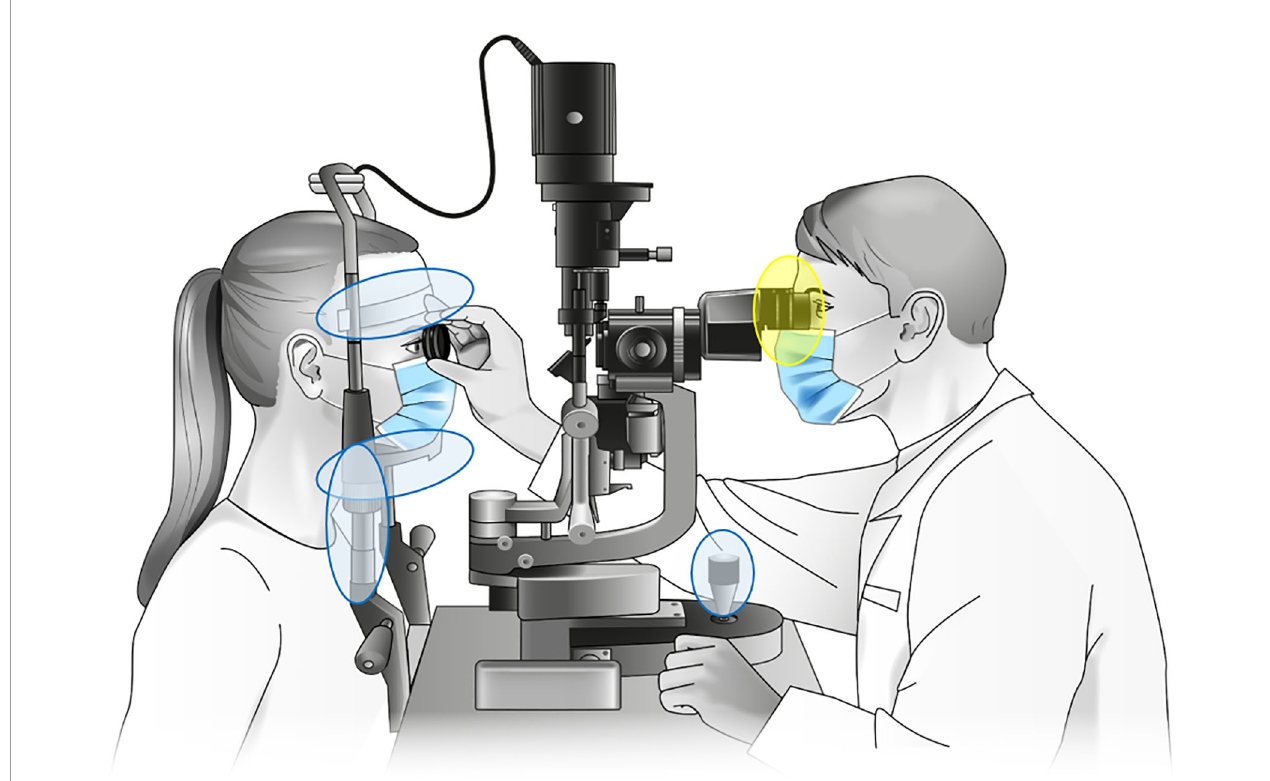
FIGURE 1 | Sampled parts of the investigated slit lamps. Samples designated “ contact area ” were taken from headrest, headband, joystick and handholders (marked blue), with probable microbial transmission between patient and physician via the handrails. Samples designated “ oculars ” were taken from the lenses and plastic eyecups (marked yellow). Slit lamp graphic: Own